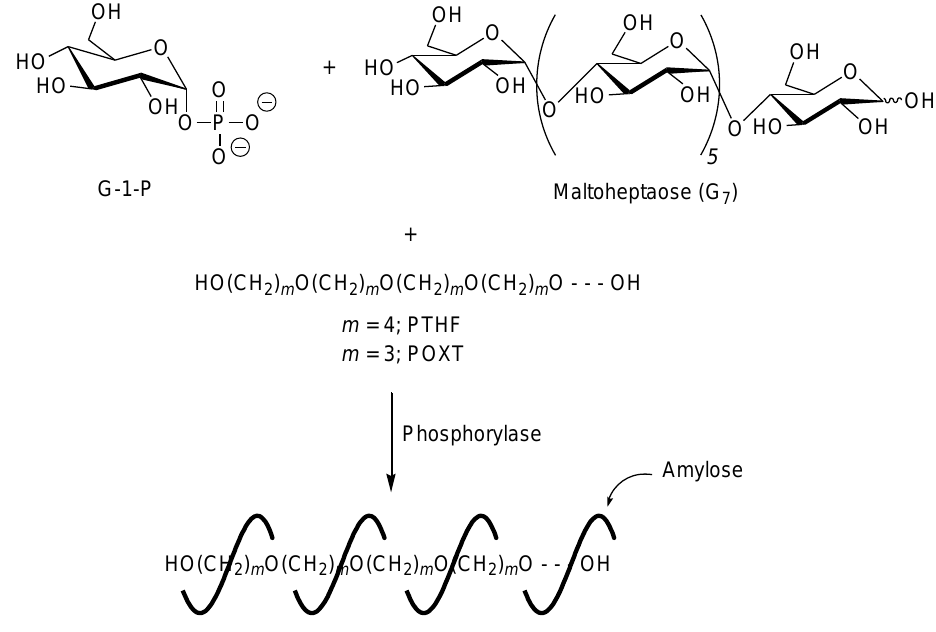
Figure 5. Architecture of inclusion complexes by vine-twining polymerization using hydrophobic guest